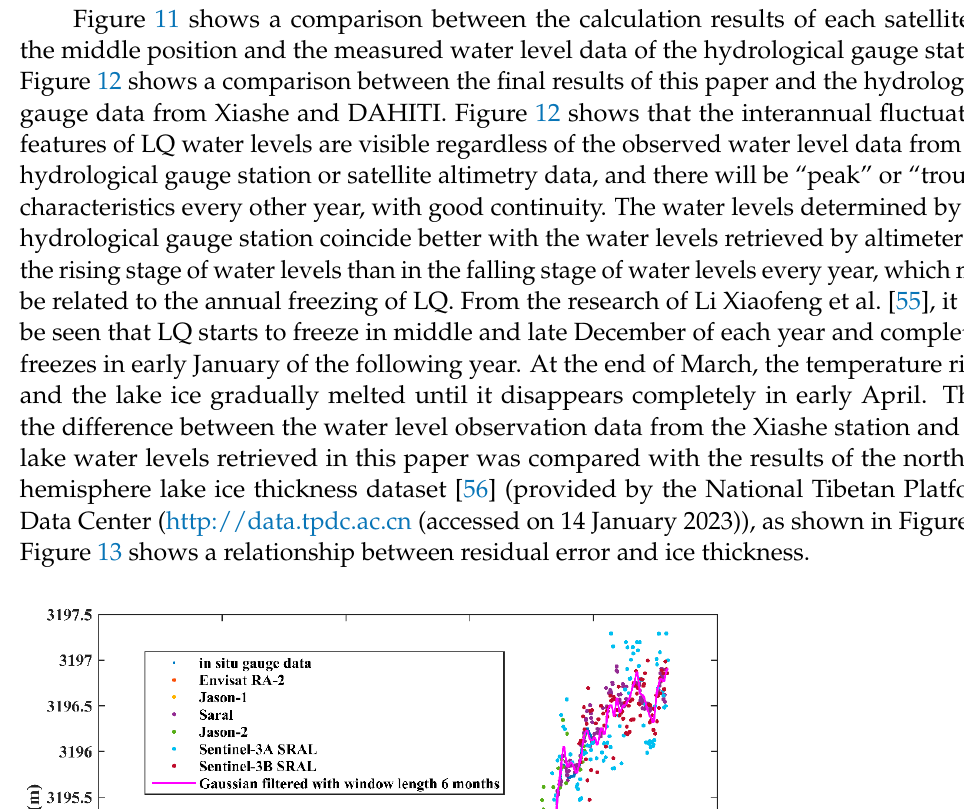
Figure 12. Comparison of the fi nal results of this paper with the hydrological gauge data from the Xiashe station and DAHITI.